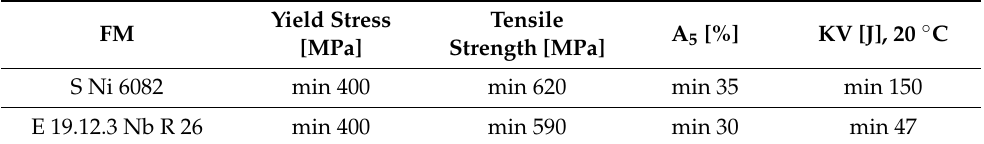
Table 4. Mechanical characteristics of the filler metals (FM). Yield Stress Tensile A 5 [%] KV [J], 20 ◦ C FM [MPa] Strength [MPa] S Ni 6082 min 47 Test specimens were made with “V” joint for 1.4093 steel and with “X” joint for Armox 500T, as shown in Figure 1. Dimension ratios for C1 specimens (steel 1.4903) are 8/10 = 0.8, and for P1 specimens (Armox 500T) are 7.4/7.5 = 0.99, which is practically square. Different shapes of the specimen cross-sections and grooves are also used to find out eventual effects of welded joint geometry on the proposed formulas for stress evaluation.